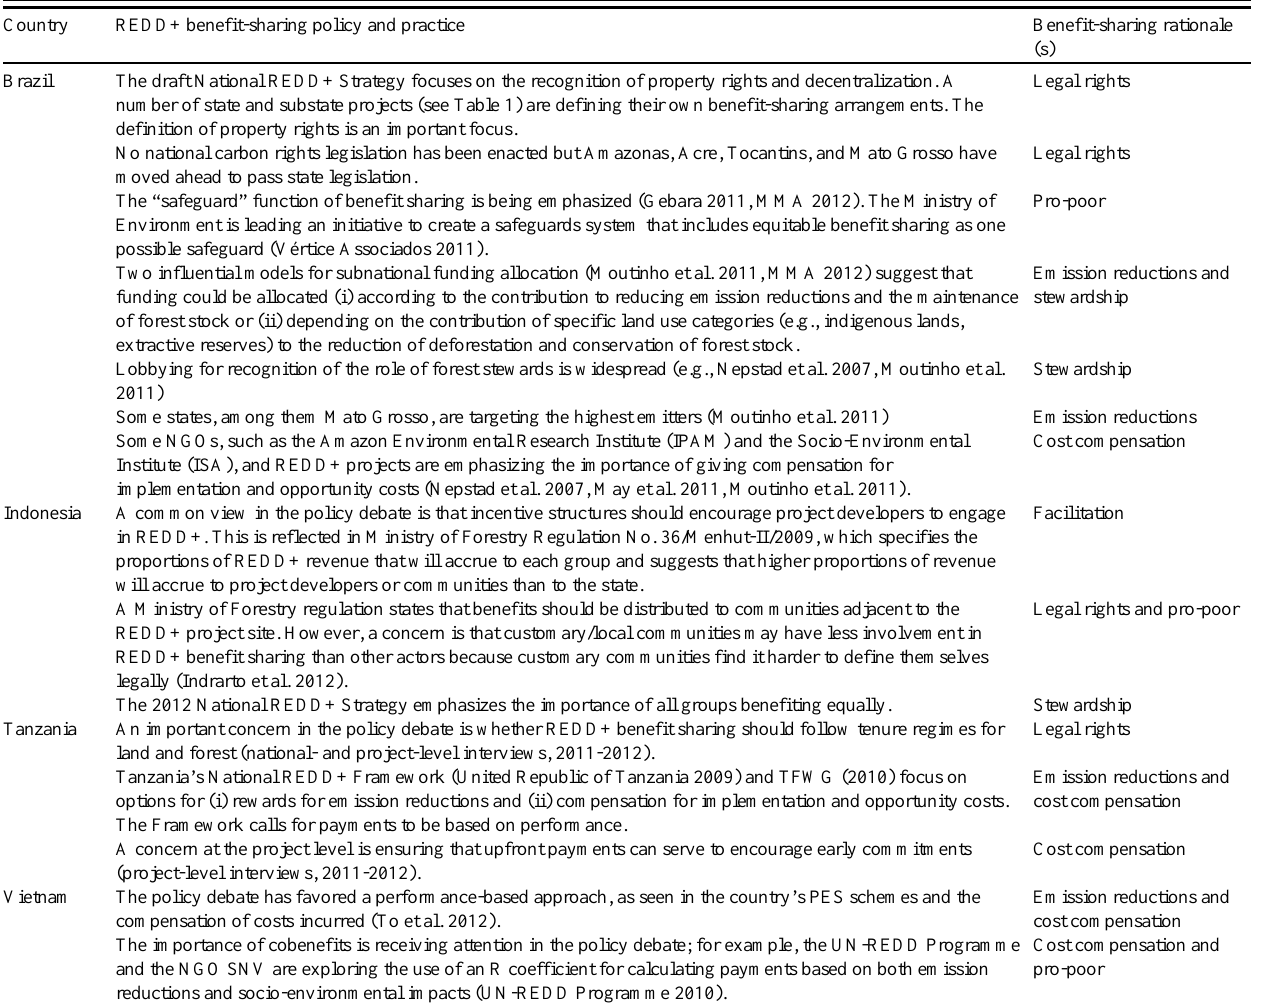
Table 2 . Examples of rationales shaping REDD+ benefit-sharing policy and practice in four key REDD+ countries (adapted from Luttrell et al.